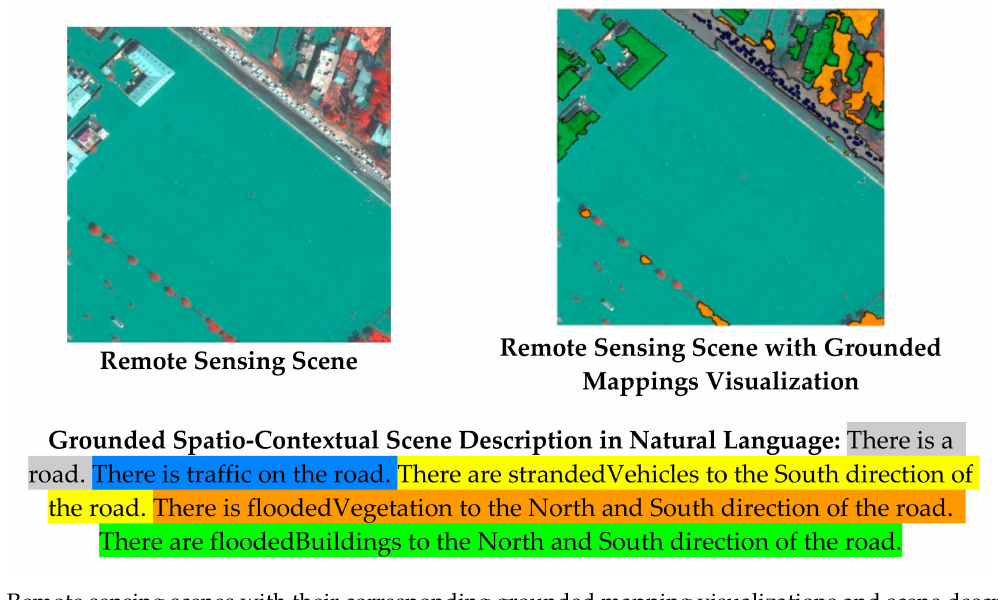
Figure 18. Remote sensing scenes with their corresponding grounded mapping visualizations and scene descriptions, as rendered by